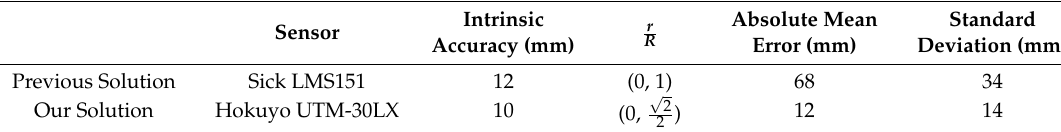
Table 2. Accuracy comparison with the previous solution.